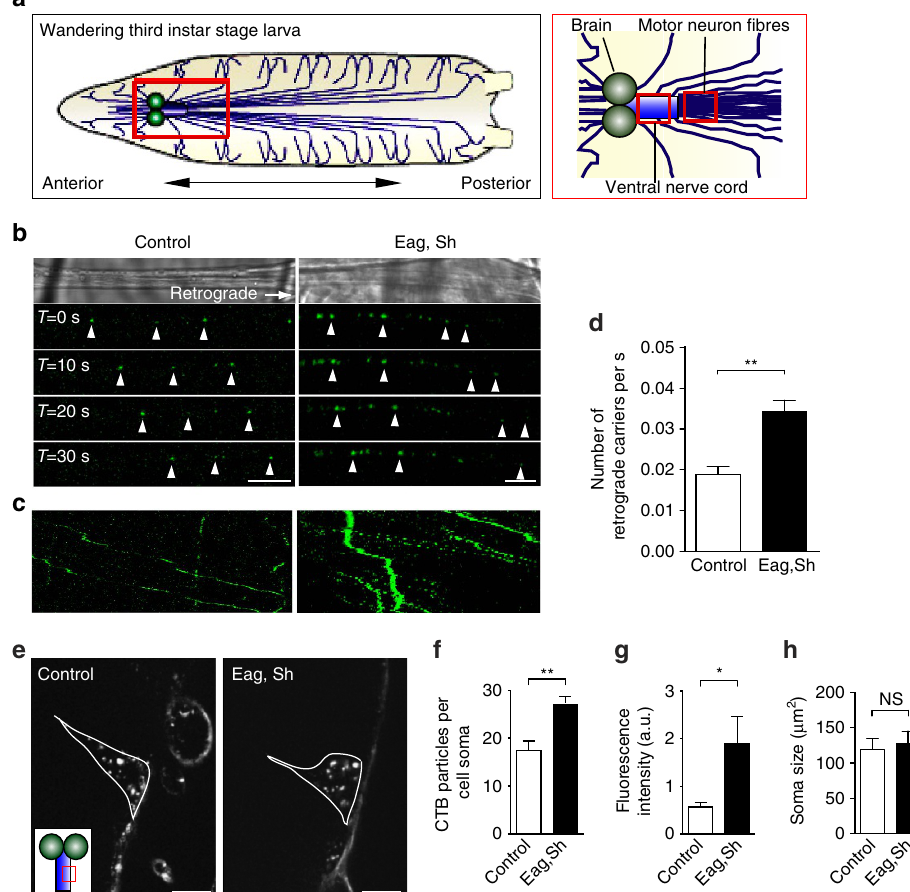
Figure 3 | CTB axonal retrograde carrier flux is controlled by synaptic activity in D. melanogaster motor neurons. ( a ) Schematic figure of a Drosophila third instar stage larva; the central nervous system is detailed on the right. ( b ) Control and eag, Sh larva preparations were incubated with CTB-Af488 for 2h, followed by time-lapse imaging by confocal microscopy. Arrowheads indicate the retrograde movement of the CTB-positive carriers along the motor neuron fibres in successive frames. Scale bar, 5 m m. ( c ) Kymographs generated from the same time-lapse movies shown in b . ( d ) Quantitative analysis of the flux of CTB-positive retrograde carriers in control, and eag, Sh Drosophila larva motor axons. (mean ± s.e.m., n ¼ 15 and n ¼ 14 for control and eag, Sh , respectively, data from four independent preparations for each condition, ** P o 0.01, Student’s t -test). ( e ) Accumulation of retrogradely transported CTB- positive cargoes in motor neuronal cell bodies located in the ventral nerve cord of control and eag, Sh larvae after 4h incubation with CTB-Af555. Inset indicates the location of the imaged cell bodies. Scale bar, 10 m m. Quantification of accumulated CTB-positive structures as number of structures per cell body ( f ) and as fluorescence intensity ( g ). The size of the motor neuronal soma was quantified in ( h ). (mean ± s.e.m., n ¼ 9 and n ¼ 10 for control and eag, Sh , respectively, data from four independent preparations, * P o 0.05, ** P o 0.01, NS, not significant, Student’s t